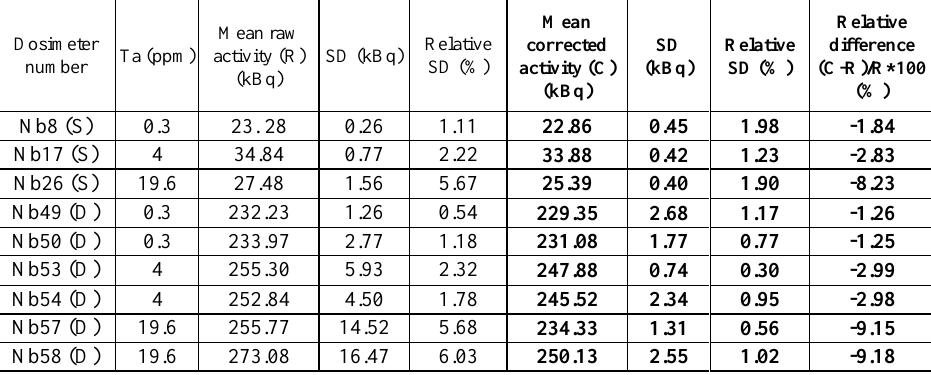
Table 3. Mean activity values and associated standard deviation (SD) without and with fluorescence corrective factors, and relative differences between